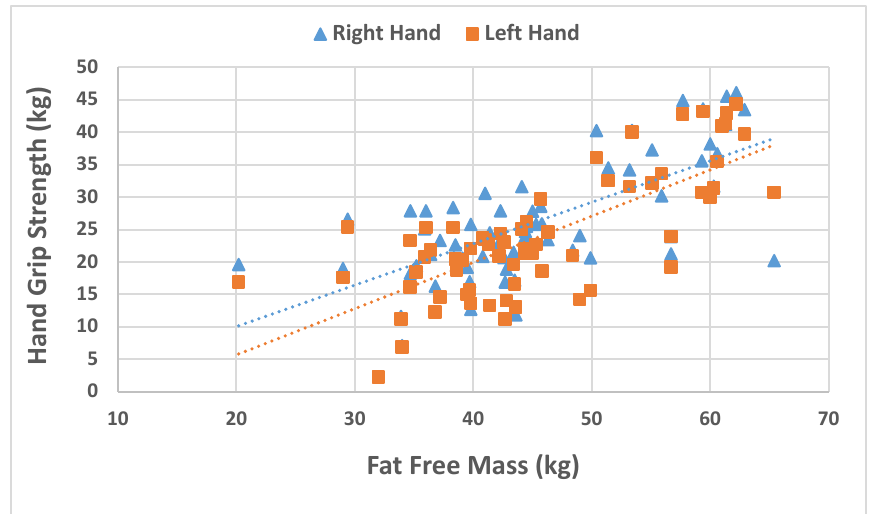
Figure 2. ( a ) Association between sit-to-stand test and age; ( b ) Association between the six minute walk test and age.